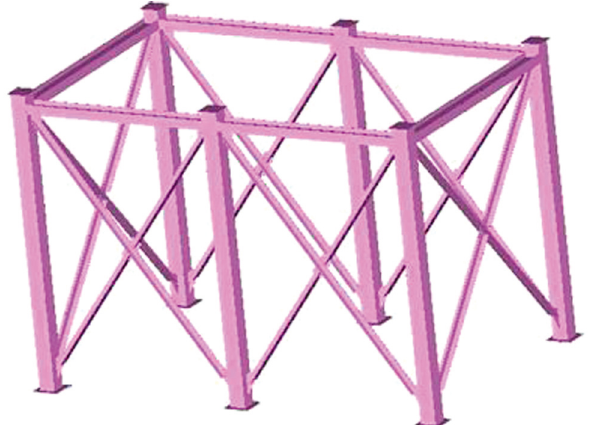
Figure 8: The model of the bracket.